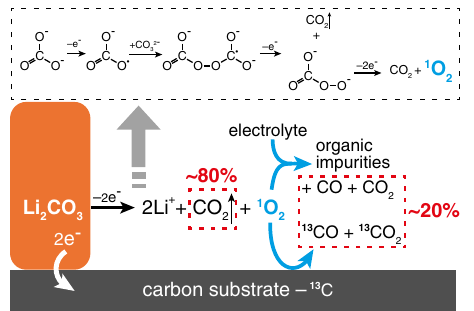
Fig. 6 | Schematics of the Li 2 CO 3 decomposition on the charging process. Li 2 CO 3 is electro-oxidized to form CO 2 and singlet O 2 ( 1 O 2 ). A possible pathway is proposed in the dash line box. 1 O 2 is highly reactive and it attacks the electrolyte and the carbon substrate to form carbon monoxide and carbon dioxide, which contribute to ~20% of the overall gas